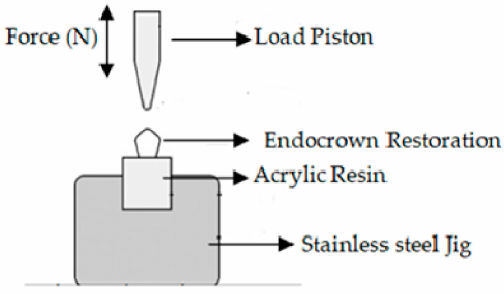
Figure 2. Device for applying fracture resistance